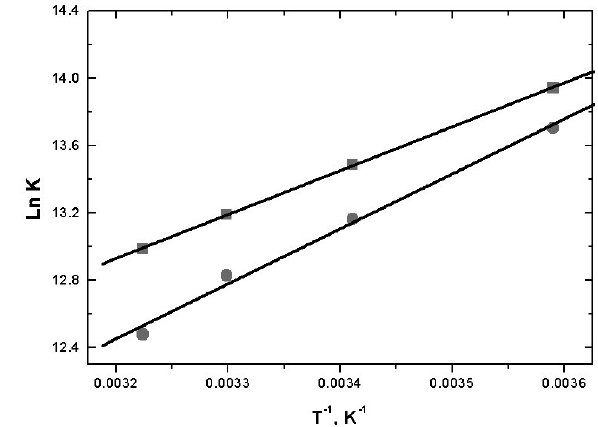
Figure 9. Van’t Hoff plot for the interaction of HSA and nandrolone decanoate drug in the presence of ionic liquids; [BMIM]BF 4 (  ) (and [BMIM]PF 6 ( 